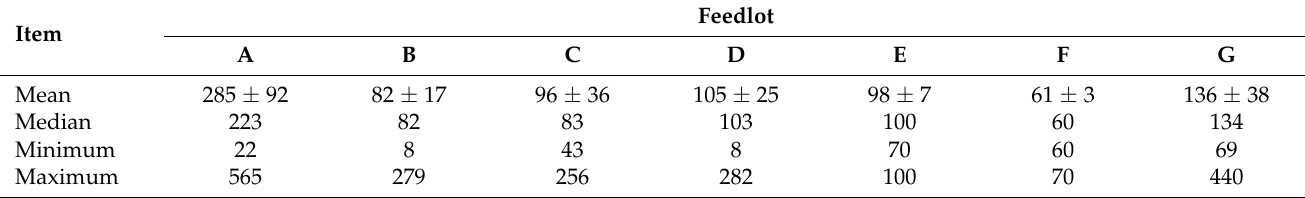
Table 3. The mean, median, minimum, and maximum days on feed for cattle from each feedlot.